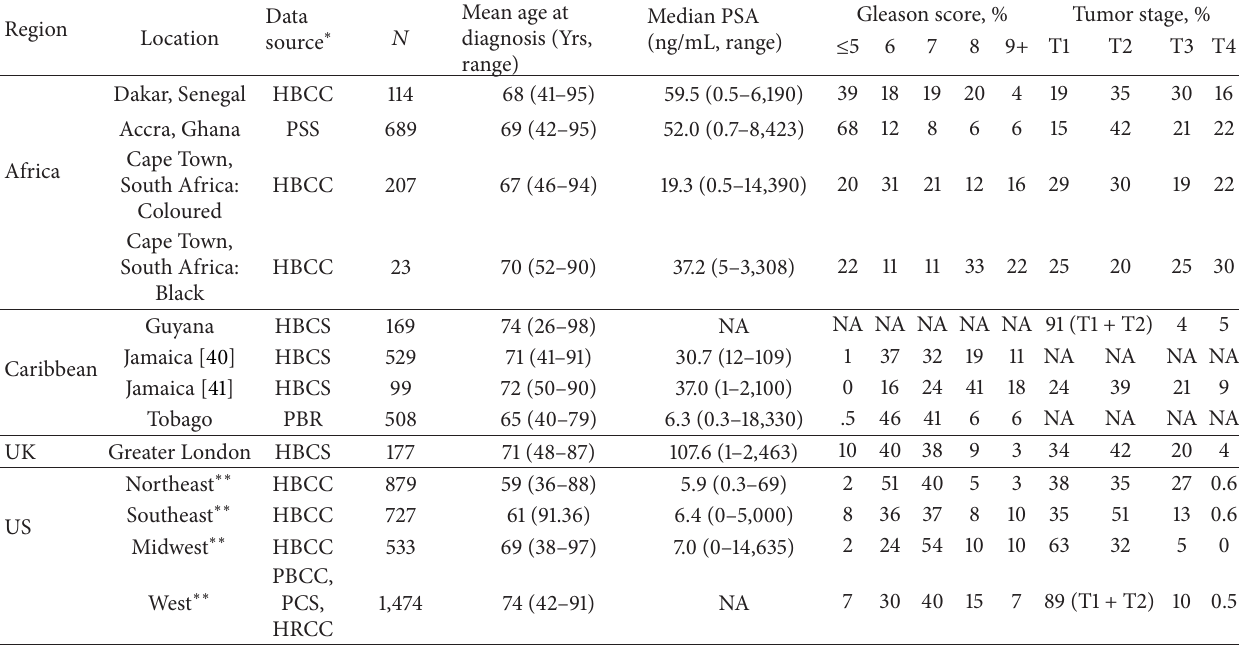
Table 2: International variation in prostate tumor characteristics in men of African